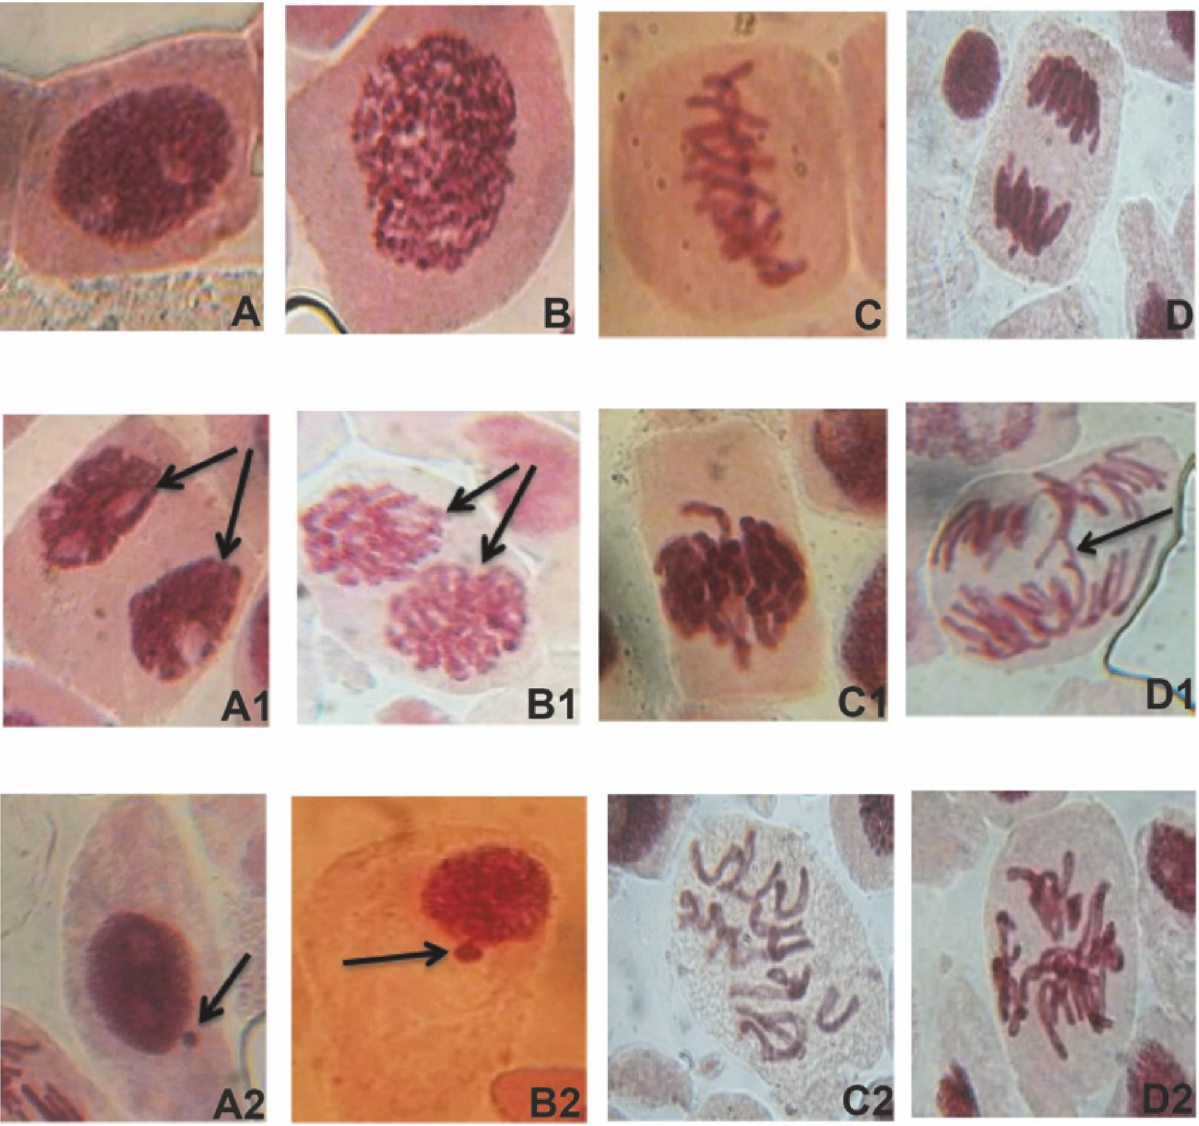
Figure 2: Micrographs of stages observed after exposure of A. cepa root tip meristematiccells to DHAP. A: normal interphase,A1: binucleiat interphase,A2: micronucleusatinterphase,B:normal prophase,B1: binucleiatprophase,B2: micronucleusatprophase,C:normal metaphase, C1: sticky metaphase, C2: C-mitosis, D: normal anaphase, D1: anaphase bridge, and D2: multipolar. Table 8: Normal mitotic activity and chromosome behavior can be recovered after short-term exposure to DHAP. Mitotic index Duration of exposure Recovery time in water